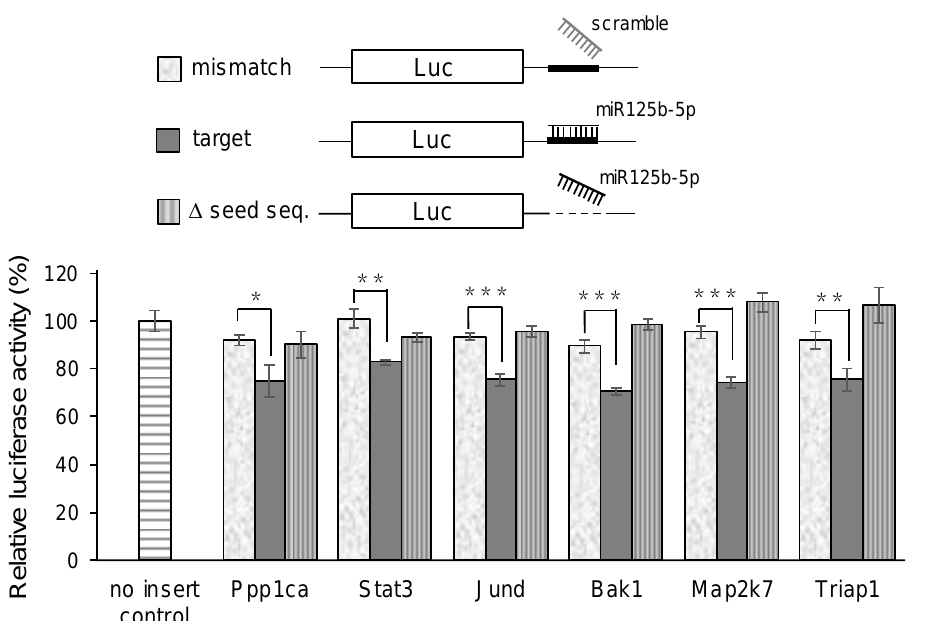
compared with the scramble control and analyzed by Student’s t -test.